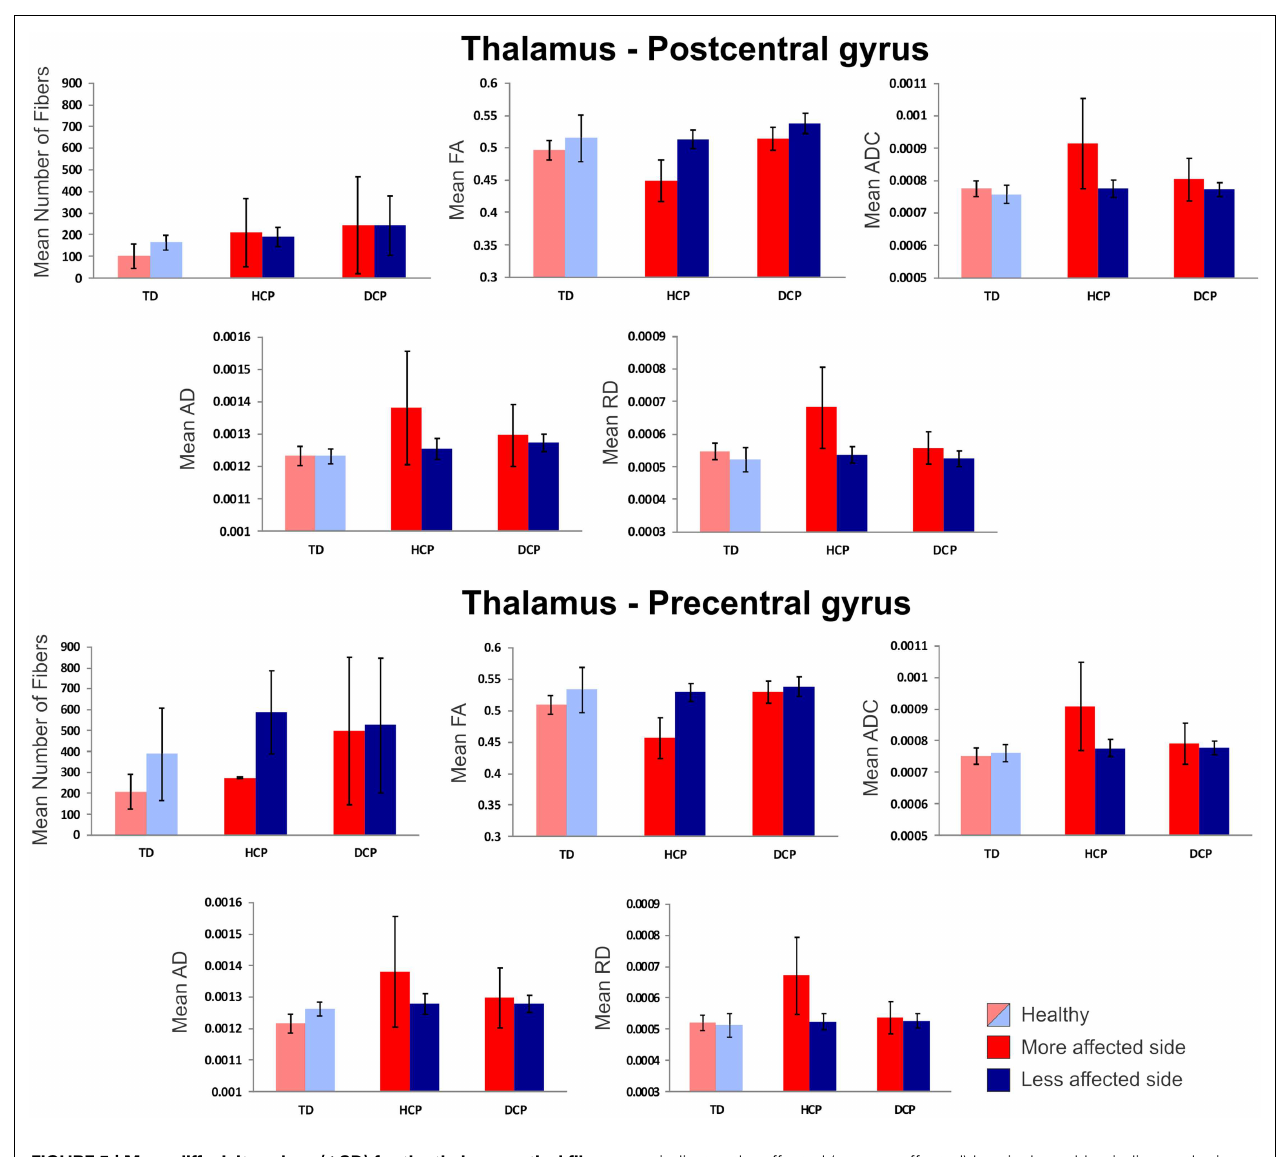
FIGURE 5 | Mean diffusivity values ( ± SD) for the thalamocortical fibers projecting from thalamus to post-central gyrus (upper panel) and thalamus to pre-central gyrus (lower panel) for all participants . Red